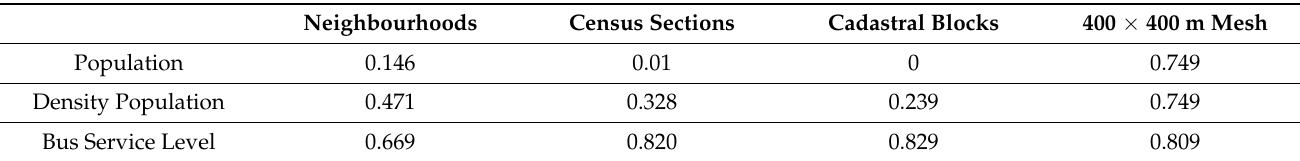
Table 3. Global Moran’s Index; significance < 0.05.